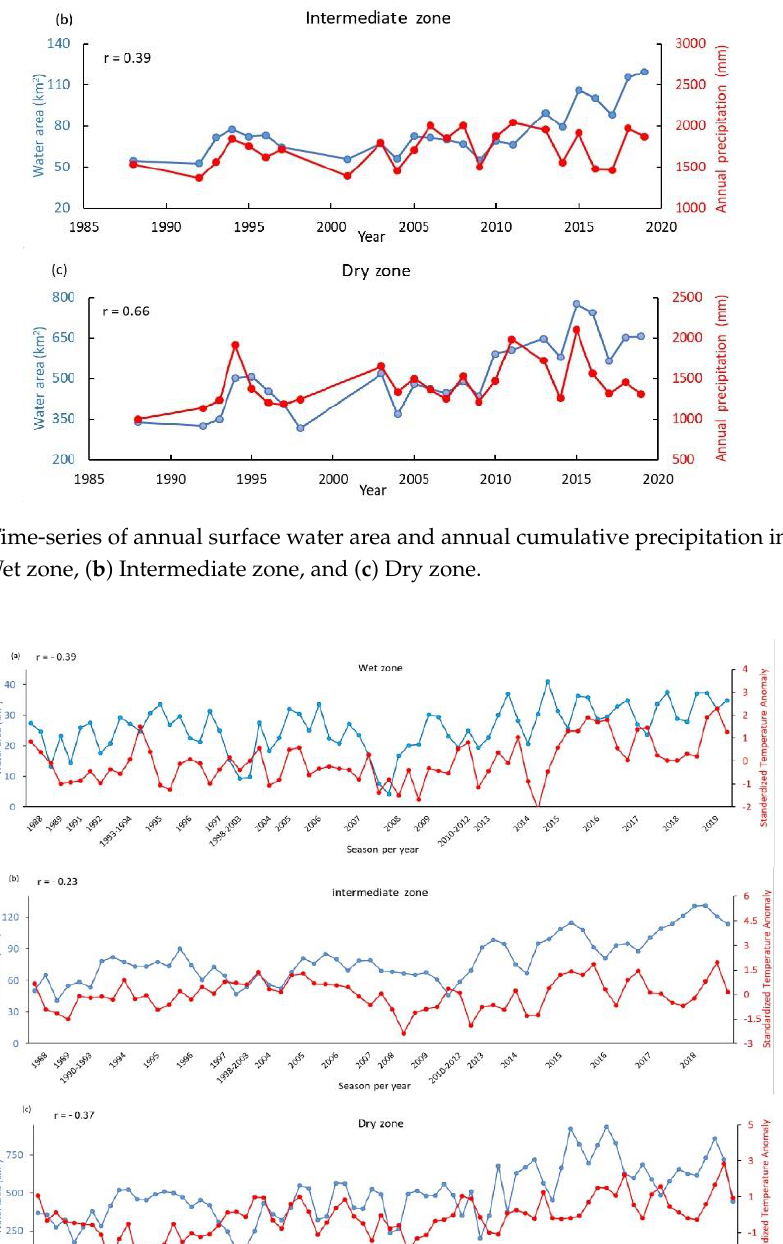
Figure 11. Time-series of seasonal standardized temperature anomaly index and water area and in different zones: ( a ) Wet zone, ( b ) Intermediate zone, and ( c ) Dry zone.